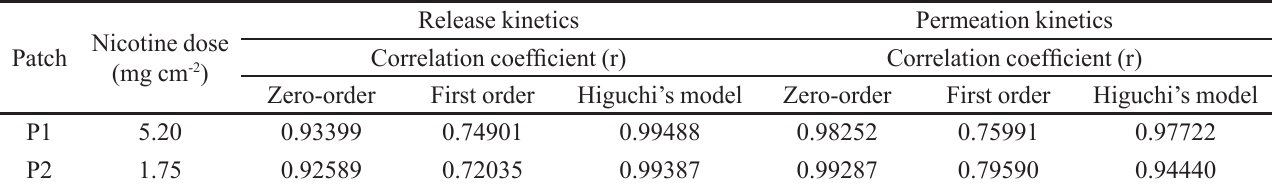
TABLE VII - Correlation coefficients determined for evaluated kinetic models